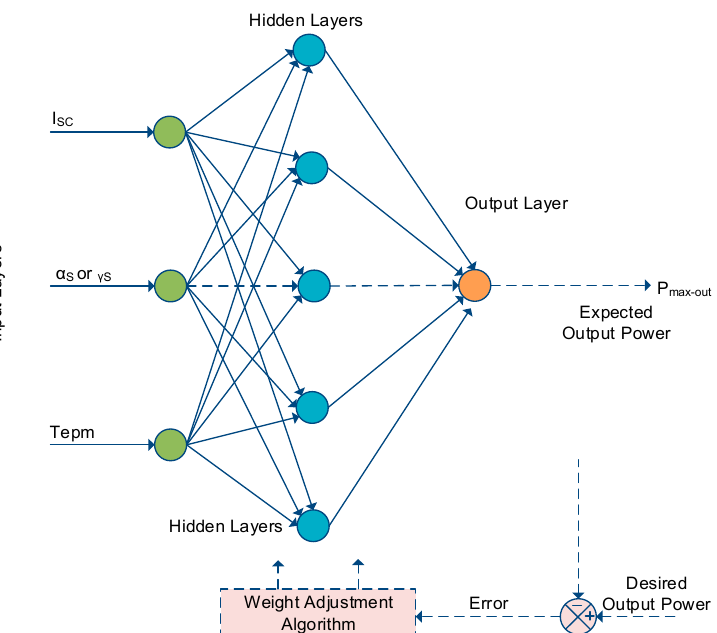
Figure 23. Feed-forward artificial neural network approximation function diagram.